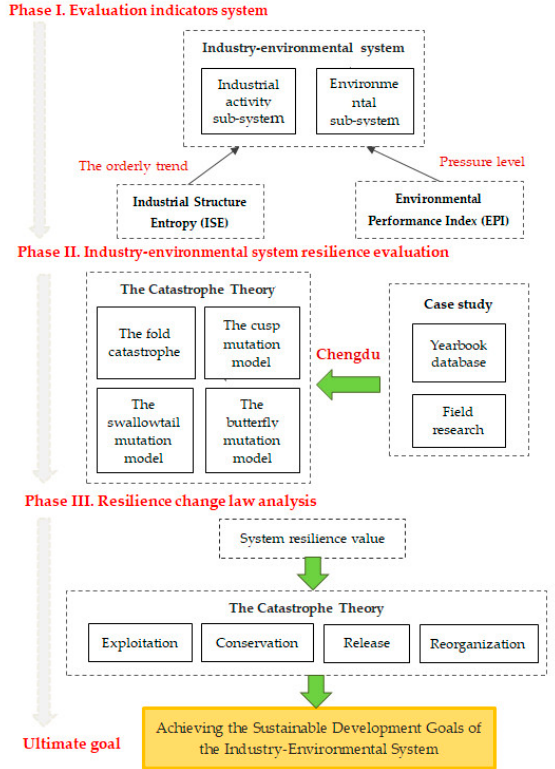
Figure 1. The flow chart of the research. Phase I: Establish a resilient evaluation index system, and use the Environmental Performance Index (EPI) and Industrial Structure Entropy (ISE) to show the pressure level of the environment system and the orderly trend of industrial activities in the indicator. Phase II: Calculate the resilience value of each index by using the catastrophe theory, and provides a basis for subsequent analysis. Phase III: Analyze the law of resilient change of the system through the adaptive cycle model, and apply it to the choice of future